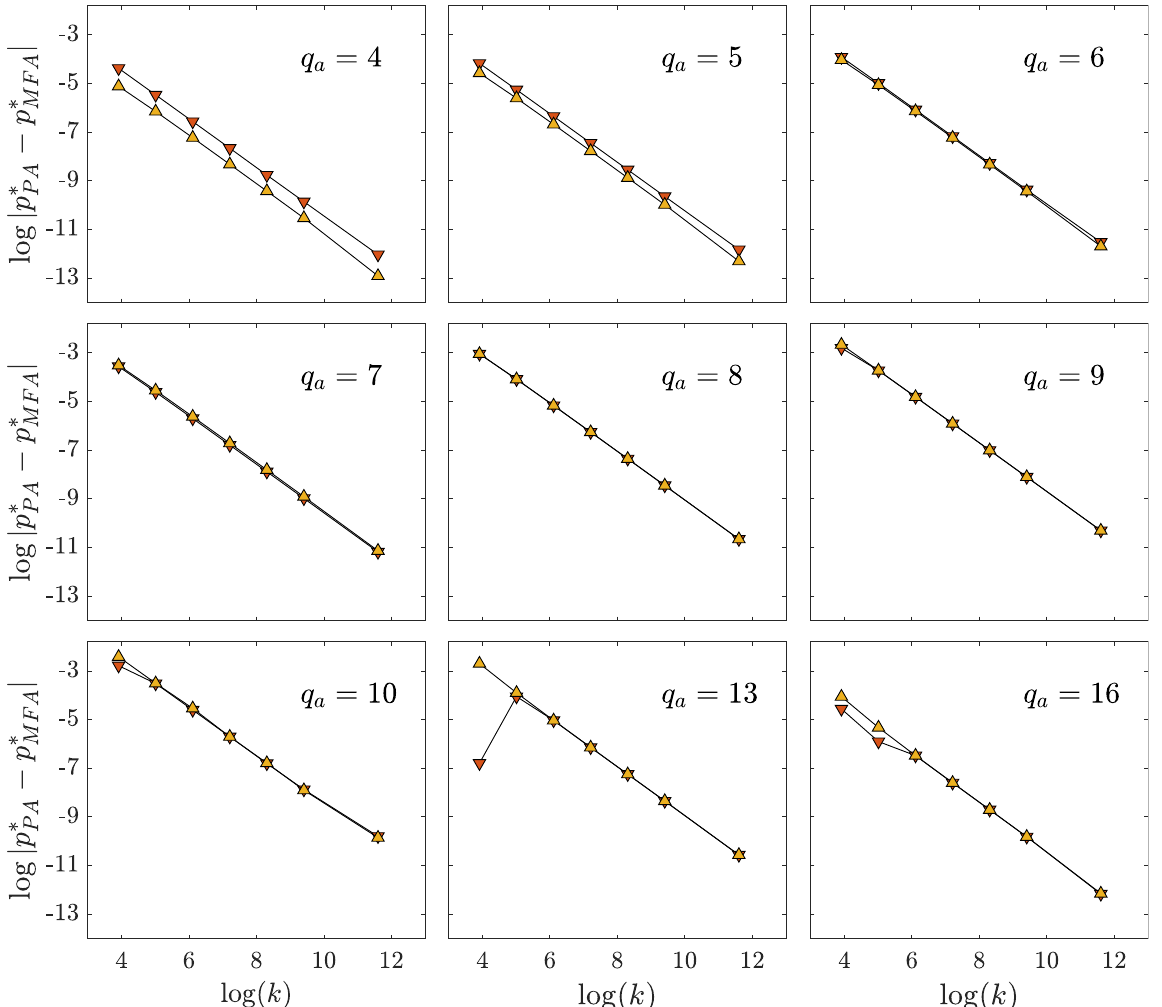
Figure 6. The absolute difference between spinodals obtained within PA and MFA as a function of k = 50 , 150, 450, 1350, 4050, 12, 150, 109, 350, for q c = 10 and different values of q a indicated in the upper right corners of the panels. Results for the upper spinodal p ∗ upper are represented by the orange down-pointing triangles, whereas for the lower one p ∗ lower by the yellow up-pointing triangles. Results are presented in the log-log scale (the natural logarithm is used here). For the lower spinodal, the power-law appears in the whole examined range of k . On the other hand, the upper spinodal deviates from the power-law for q a ≥ q c − 1 for small values of k . It should be noticed that simultaneously for these values of parameters PA wrongly predicts discontinuous phase transition, i.e. p ∗ upper �= p ∗ lower , whereas MFA indicates the continuous one, i.e. p ∗ upper = p ∗ lower